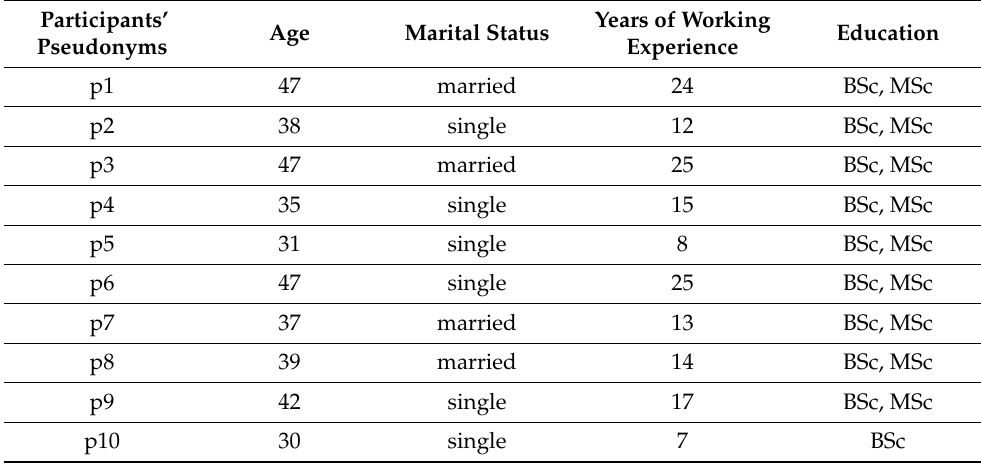
Table 3. Demographic characteristics of study